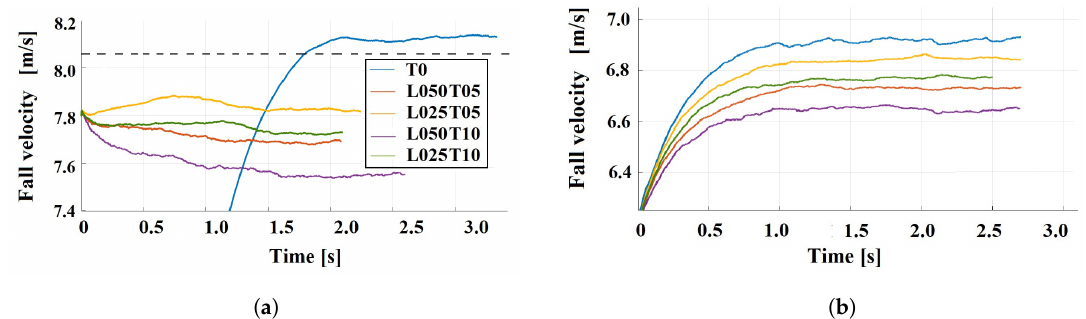
Figure 5. Simulated fall velocities of the 3 mm and 2 mm water drops over time: ( a ) D = 3 mm. ( b ) D = 2 mm. In the 3 mm drop case D3T0, the curve is obtained from the validation case. For all other cases, the initial mean velocity of the incoming air flow was set to 7.8 m/s and 6.2 m/s for the 3 mm and 2 mm drops, respectively.